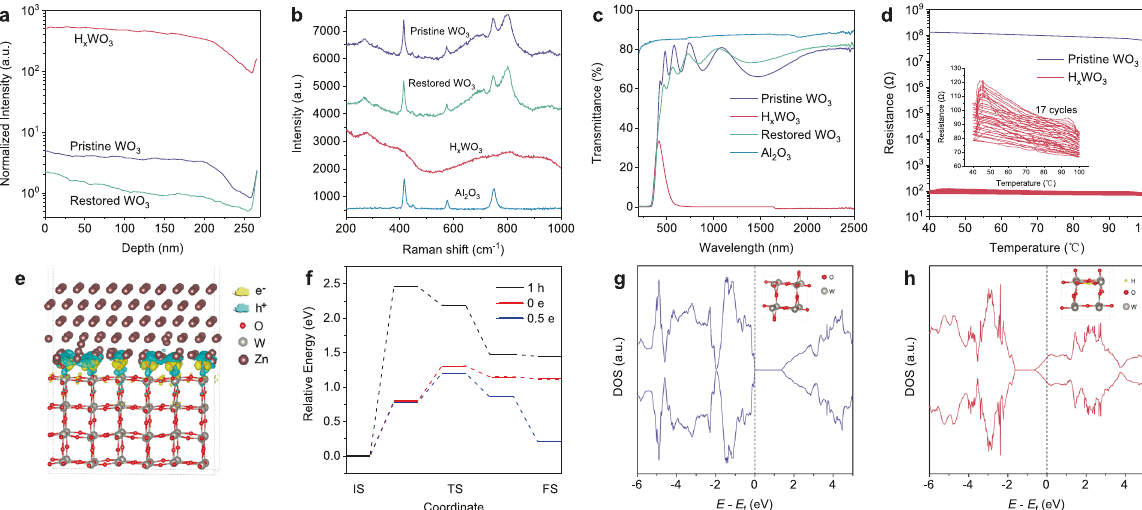
Fig. 2 The characterizations and theoretical calculations for the electron doping WO 3 fi lm. a The secondary-ion mass spectrum (SIMS) tests for the WO 3 fi lm after treated by electron – proton synergistic doping route, labeled by H x WO 3 . Then the H x WO 3 annealed at 300 °C in air leads to the restored WO 3 sample. b The Raman peak at 802 cm − 1 for pristine WO 3 fi lm is disappeared in H x WO 3 . While it can be restored after annealing the H x WO 3 sample. c The UV – Vis – infrared transmission curves for the pristine WO 3 , the H x WO 3 and the restored WO 3 samples. d Resistance – temperature ( R – T ) results show the resistance of pristine WO 3 fi lm is quite stable within the temperature from 40 to 100 degrees, while it will decrease with six orders of magnitude after the fi lm was hydrogenated to H x WO 3 , indicating a pronounced metal – insulator transition (MIT). The inset is the R – T cycle test in air, showing the metallic H x WO 3 is quite stable at ambient. e Computed differential charge distribution at Zn/WO 3 interface. Isosurface is 0.005 electrons per Å 3 . f Energy diagram along the reaction pathways of H migrating from WO 3 surface (initial state: IS) to subsurface ( fi nal state: FS) via the transition state (TS). Energy of IS is set as zero. g , h Density of states (DOS) of WO 3 ( g ) and H-doped WO 3 ( h ), together with inset photographs for the atomic models.